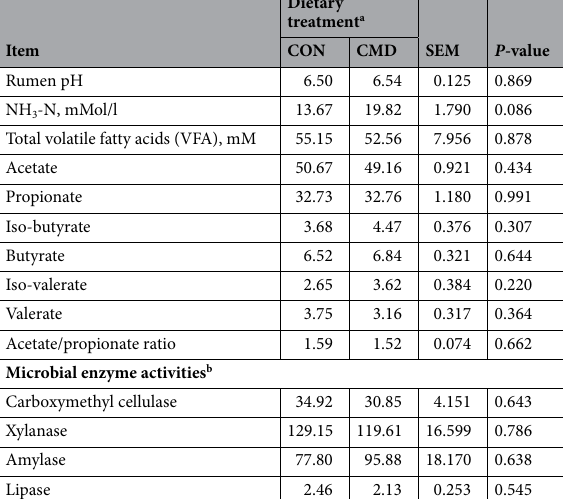
Table 3. Rumen pH, fermentation traits and microbial enzyme activities in lambs fed concentrate diets containing dehydrated lucerne (CON) or cardoon meal (CMD). SEM pooled standard error of the mean. a CON control diet, CMD cardoon meal diet. b Specific activity of carboxymethyl cellulase, xylanase and amylase were expressed as mg of sugar released per g of protein per min while lipase activity was expressed as mM PNP per g of protein per